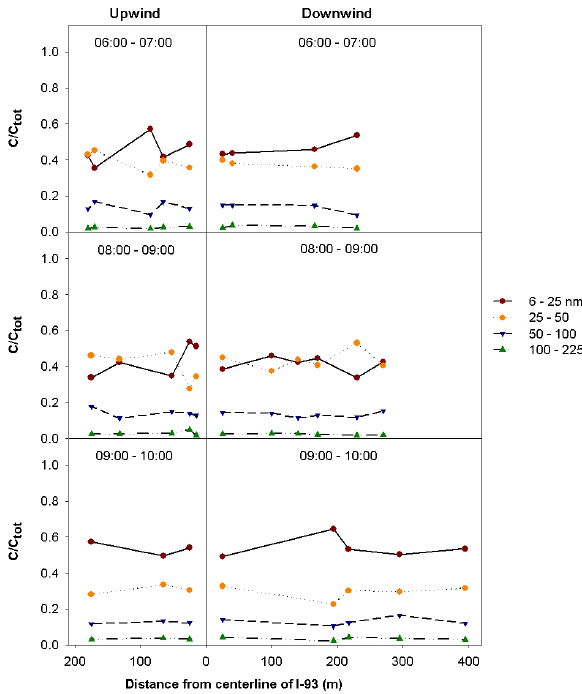
Fig. 5. Spatial and temporal variation of particle size distribution along upwind and downwind transects perpendicular to